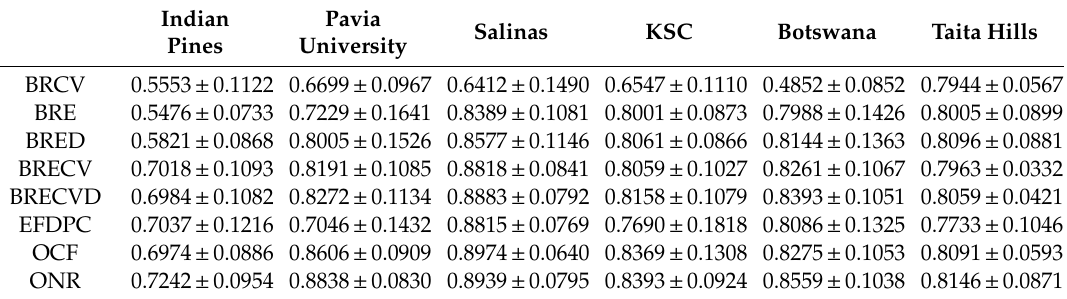
Table 2. OAs by SVM with standard deviation averaged over 30 selected bands.